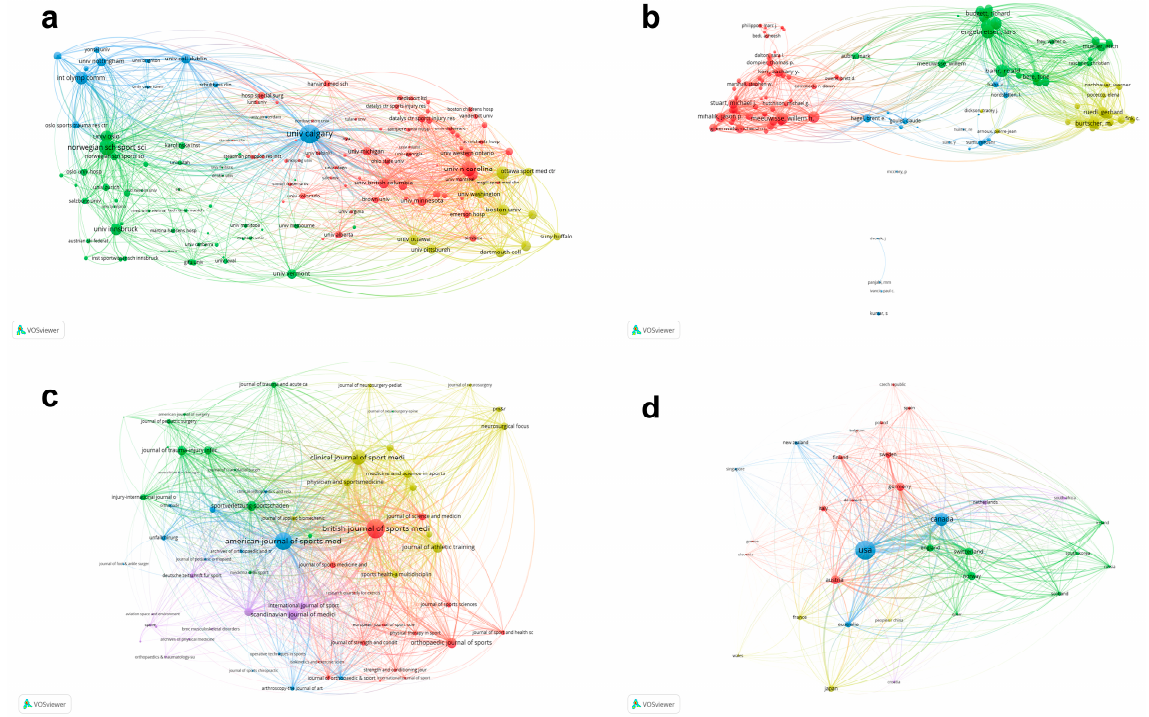
Figure 5. Bibliographic coupling analysis of global research about ice and snow sports injuries. ( a ) Network visualization mapping for the 140 identified affiliations. ( b ) Network visualization map- ping for the 128 identified authors. ( c ) Network visualization mapping for the 65 identified journals. ( d ) Network visualization mapping for the 32 identified countries/regions. The size of the nodes and lines between two nodes indicate a proportional relationship to the similarity of the affiliations/au- thors/journals and countries/regions.